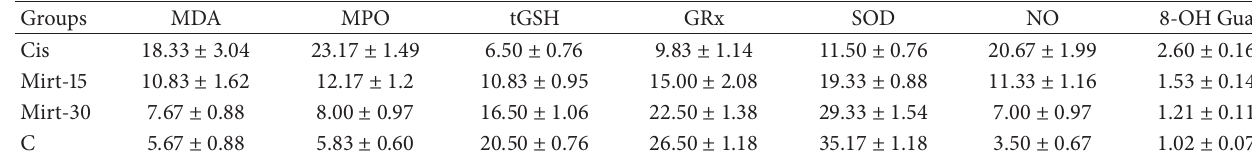
Table 1: Oxidative stress and DNA damage parameters in the study groups.